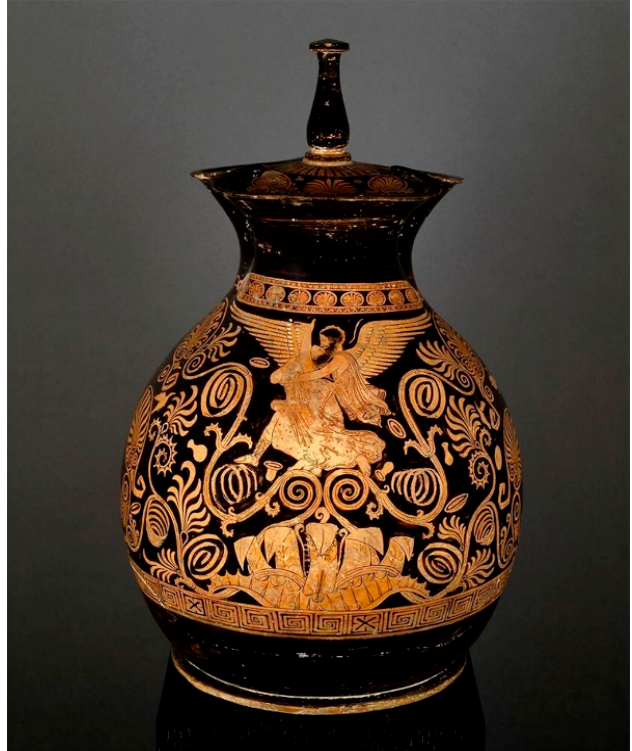
Figure 1. Paris, Louvre K 35 Apulian chous, Salting Painter, ca. 360 B.C. Boreas and Oreithyia among